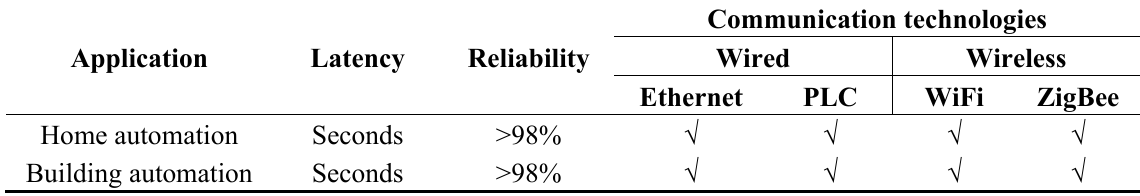
Table 1. Network requirements for customer premises applications